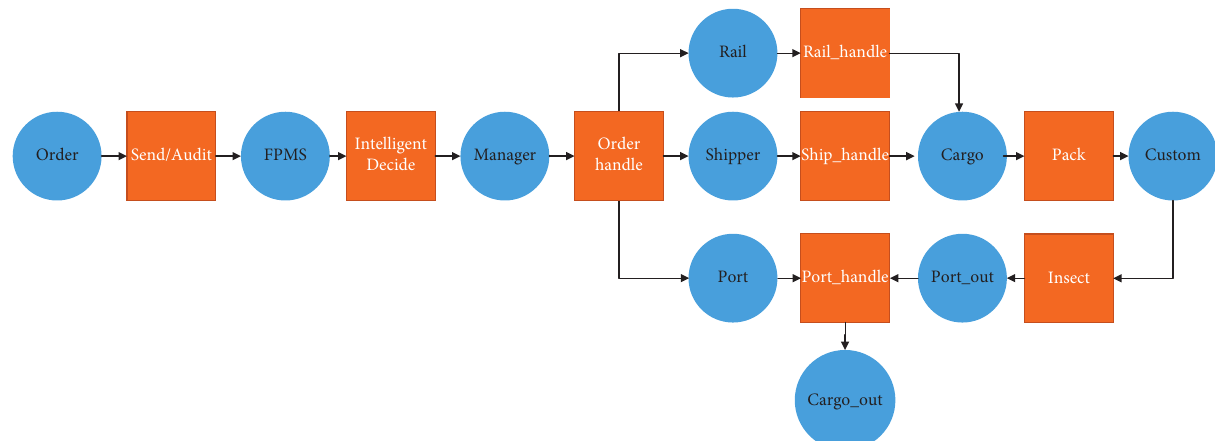
Figure 9: Process simulation screenshot after reconstruction.